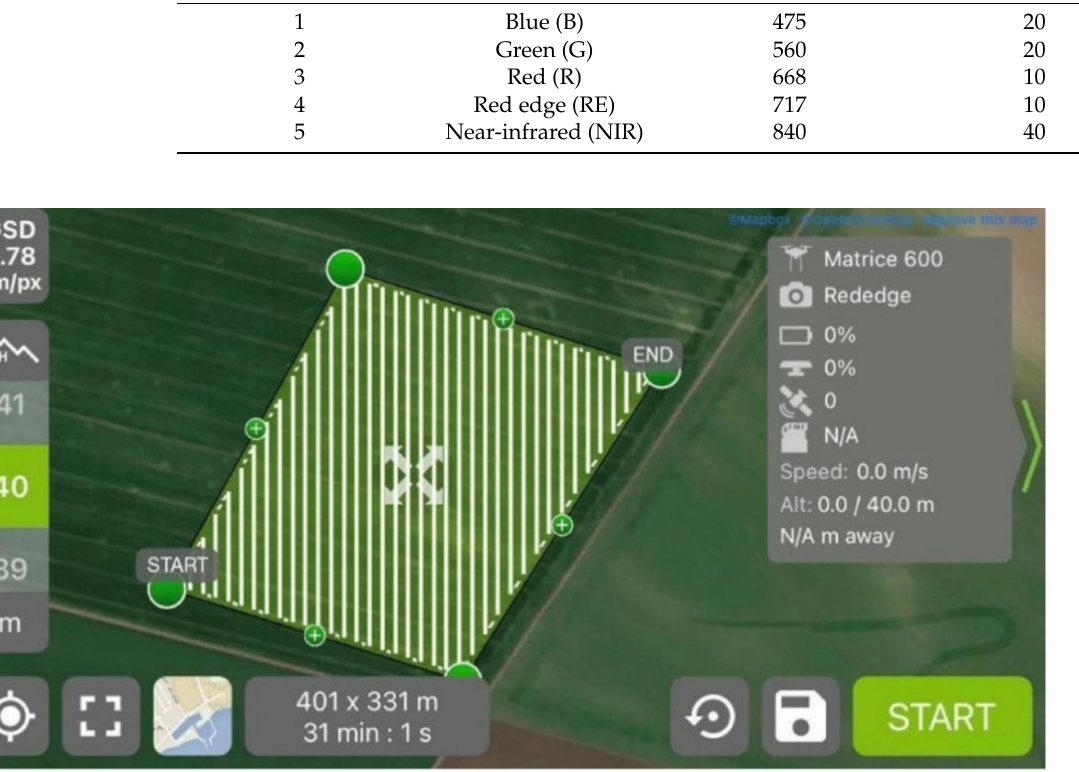
Figure 4. The area of interest visualized in Pix4D